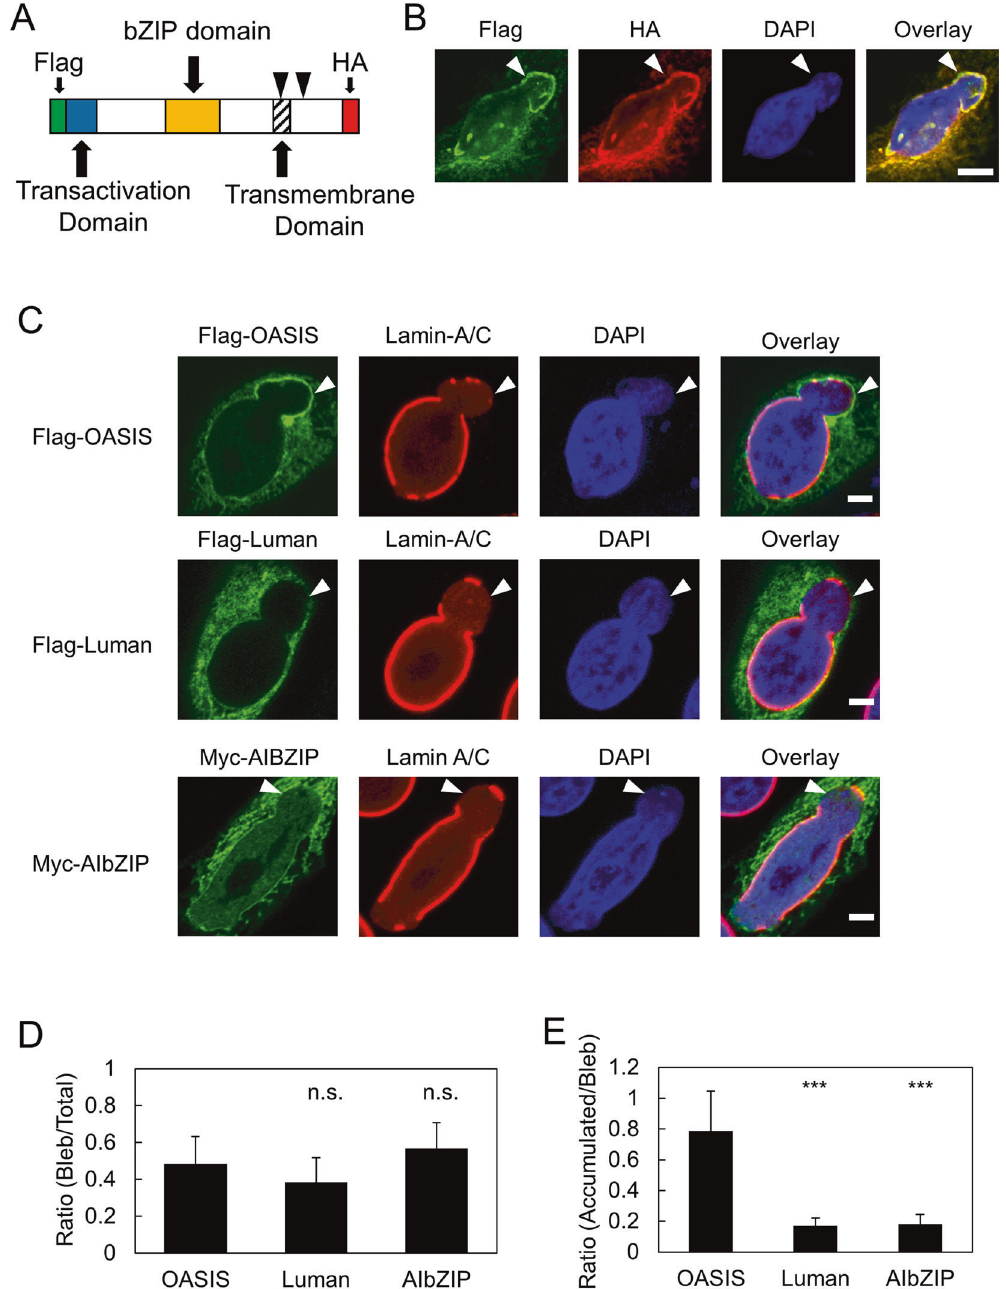
Fig. 2 Full-length OASIS speci fi cally accumulates on damaged NE among OASIS family proteins. A Schematic representation of the domain structure of OASIS. Arrowheads indicate the cleavage sites of OASIS. B Immuno fl uorescence staining analysis of Flag and HA in shLMNB1 cells expressing Flag-OASIS-HA. Arrowhead indicates a nuclear bleb where OASIS accumulates. C Immuno fl uorescence staining analysis of Flag- OASIS, Flag-Luman, or Myc-AIbZIP in shLMNB1 cells in which nuclear blebs formed. Arrowheads indicate nuclear blebs. D Quanti fi cation of the ratio of cells in which nuclear blebs formed relative to total Flag-OASIS-, Flag-Luman-, and Myc-AIbZIP-expressing cells. Bars and error bars represent the mean values and SD from three independent experiments. Statistical signi fi cance of the difference was determined using Fisher ’ s exact test. n.s. p > 0.05. n = 59 OASIS, n = 78 Luman, n = 55 AIbZIP. E Quanti fi cation of the ratio of cells in which Flag-OASIS, Flag- Luman, or Myc-AIbZIP accumulate at nuclear blebs relative to total nuclear bleb positive cells expressing the indicated protein. Bars and error bars represent the mean values and SD from three independent experiments. The statistical signi fi cance of differences was determined using Fisher ’ s exact test. n.s. p > 0.05. *** p < 0.005. n = 30 OASIS, n = 31 Luman, n = 39 AIbZIP. Scale bars: 5 μ m.